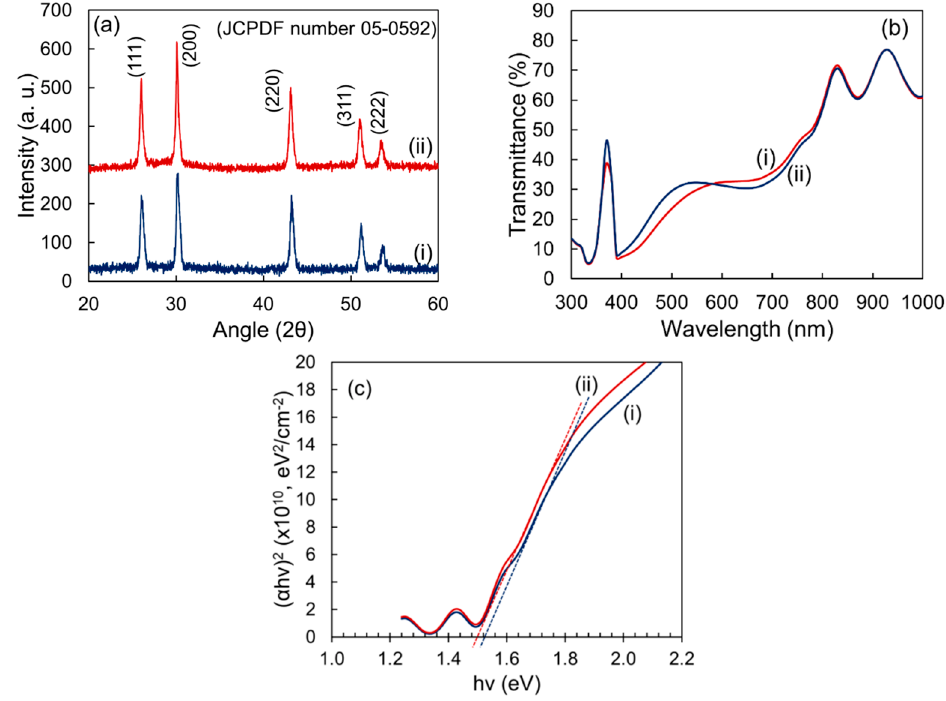
Figure 6. ( a ) XRD patterns, ( b ) transmittance spectra, and ( c ) Tauc plot of the thin film fabricated from the two different solution concentrations of PbS nanoparticles, (i) 5 mg mL − 1 and (ii) 10 mg mL − 1 . Table 2. Estimated structural and electrical properties of the PbS thin films with respect to the solution